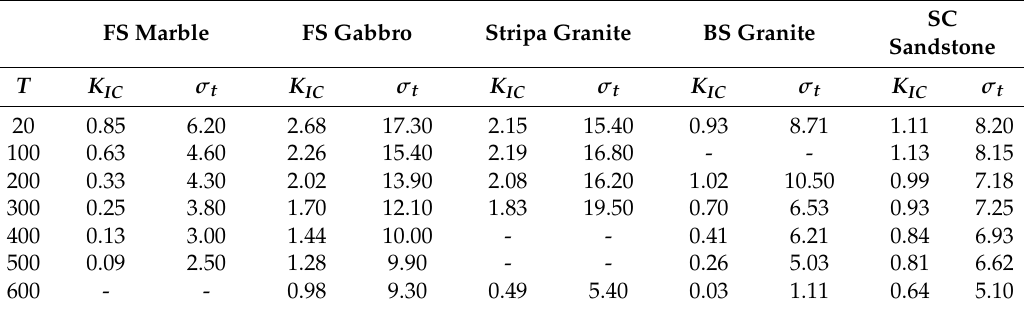
Table 2. Fracture toughness and tensile strength of